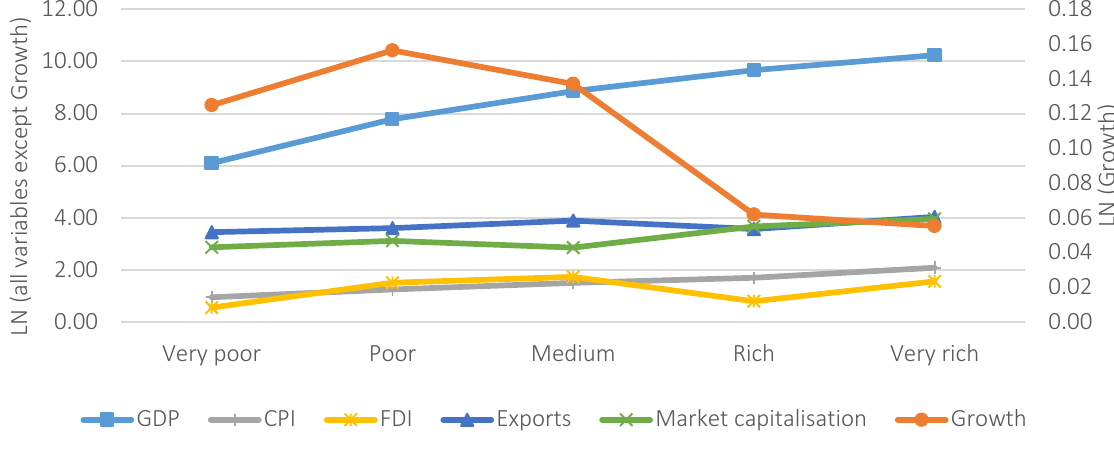
Figure 1. Interactions between measures in 2008 and